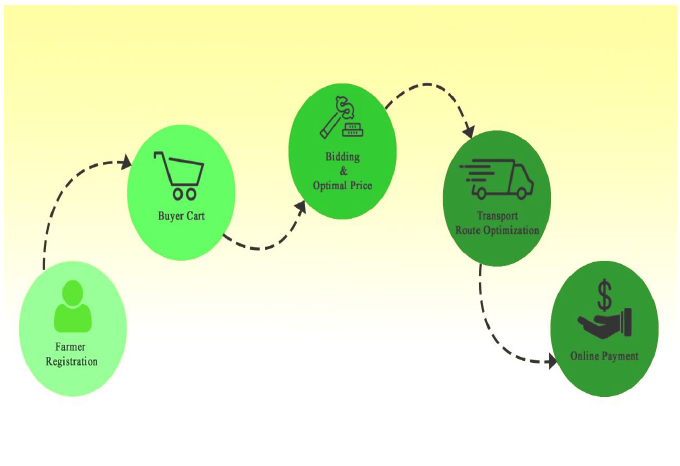
Figure 2. Process flow diagram of our proposed decision support system